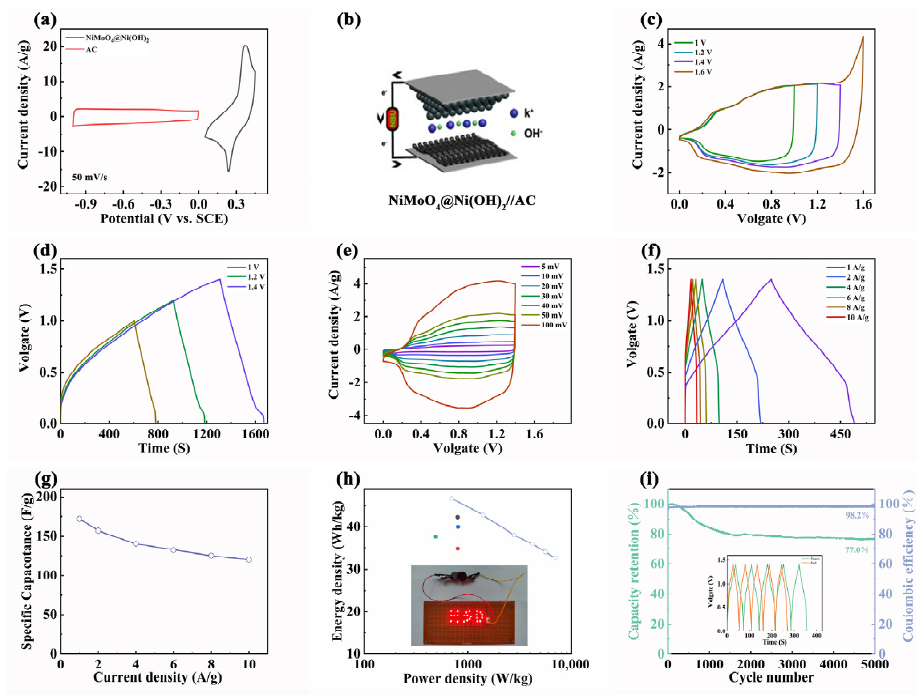
Figure 8. ( a ) CV curves of NMH − 2 and AC in three − electrode systems. The energy storage performance of the NMH − 2//AC. ( b ) the demonstration of the device. ( c ) CV curves under different working voltages at 50 mV/s. ( d ) GCD curves under various working voltages at 1 A/g. ( e ) CV curves at 5–100 mV/s. ( f ) GCD curves at 1–10 A/g. ( g ) Specific capacitances at 1–10 A/g. ( h ) Ragone plots. ( i ) Capacitance retention and Coulombic efficiency during cycling at 10